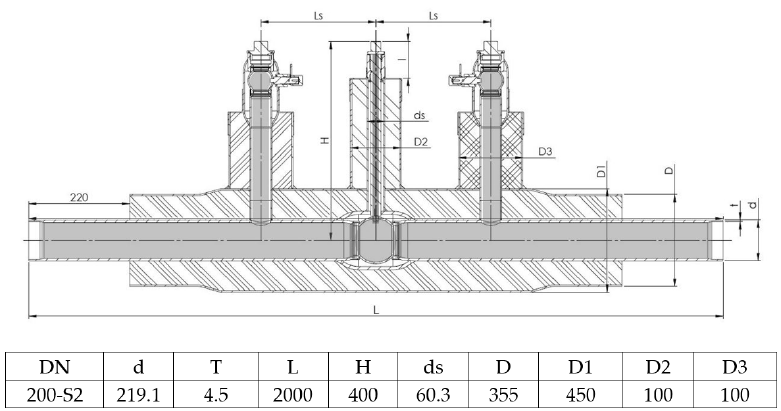
Figure 6. Illustration of valves: an open/close ball valve in the middle and drainage valves to the left and right. The grey shading represents the medium water in a pressurised system (illustration modified from Broen [11]).